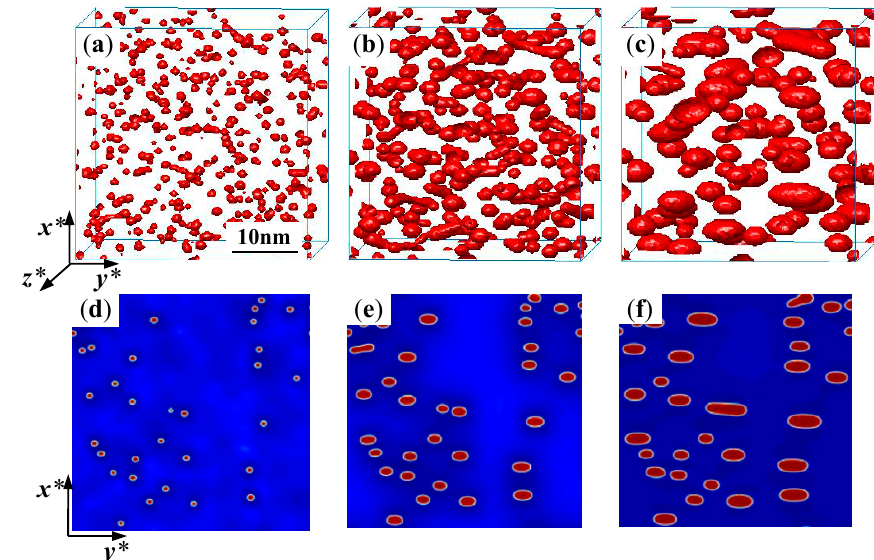
Figure 1. The temporal evolution of α′ phase in Fe-25 at. % Cr alloy aged at 750 K under the applied uniaxial tensile strain 0.02, ( a ) and ( d ) t = 115 h, ( b ) and ( e ) t = 805 h, ( c ) and ( f ) t = 3450 h, ( a ) ‒ ( c ) 3D morphology, ( d ) ‒ ( f ) 2D morphology.